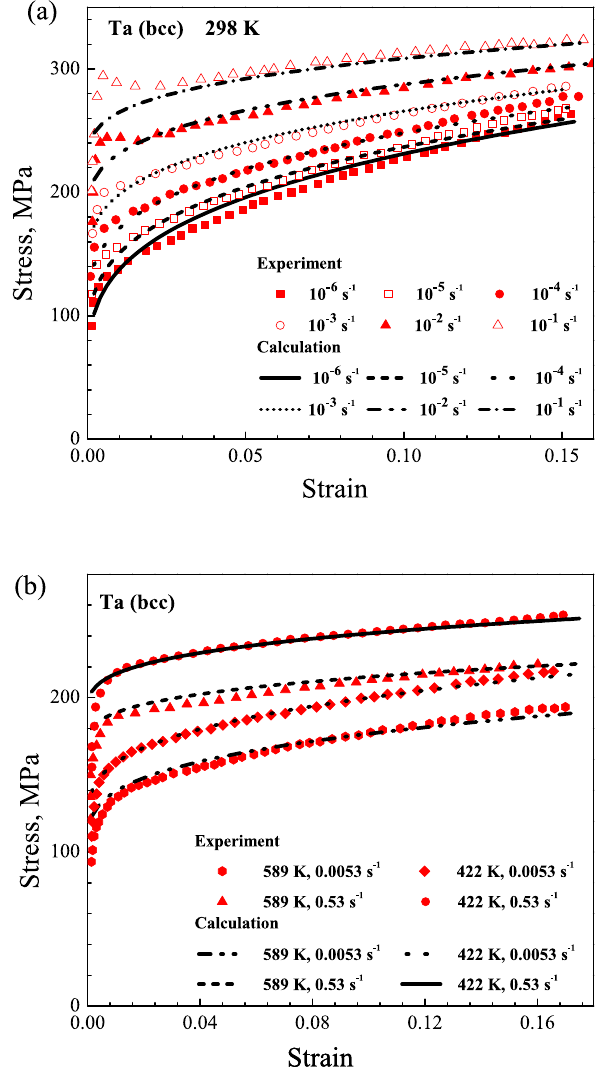
Figure 3. Comparison of stress–strain curves for Ta between the calculated and experimental results at different temperatures and strain